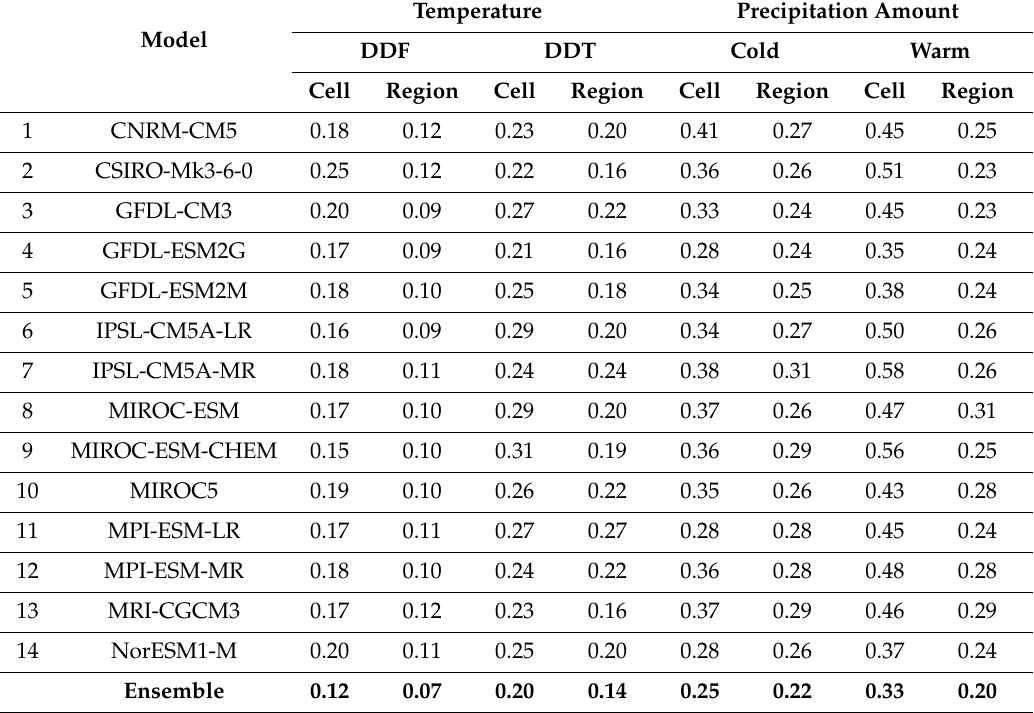
Table 3. Root mean square deviations (RMSD) of CMIP5 models datasets and their ensemble from the data of reanalysis NCEP / NCAR for accumulated temperature (DDT and DDF, ◦ C-days) and precipitation amount in warm and cold periods (cm) in fractions from long-term average annual value (1948–2010). The nearest grid cell to the CALM site 0.5 × 0.5 ◦ and averaged value for the region 63–70 ◦ N and 165 ◦ E–168 ◦ W were considered. Temperature Precipitation Model